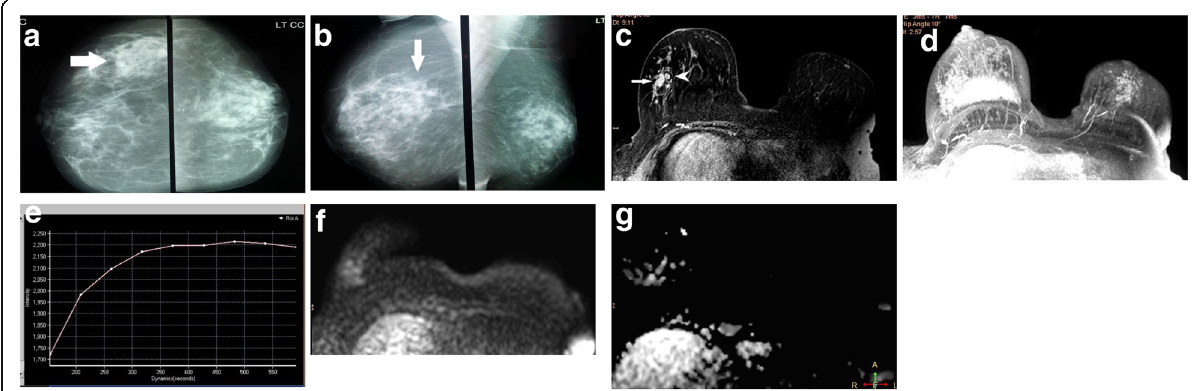
Fig. 4 A 45-year-old female patient with right breast lump. Mammography craniocaudal ( a ) and mediolateral oblique ( b ) views show focal asymmetry (arrow) in the right upper outer quadrant (BIRADS IV lesion). Axial TI contrast-enhanced fat-suppressed image on dynamic sequence ( c ) showed homogenous segmental non-mass enhancement (NME) (arrow) with well-defined enhanced intraductal lesion (arrow head). Axial MIP image ( d ) shows the right breast non-mass enhancement with increased vascularity to right breast. Dynamic time-intensity curve ( e ) shows type II “ plateau ” curve. The lesion elicits faint high signal intensity on DWI at b value = 400 ( f ) with a mean ADC value of 1.2 × 10 – 3 cm/s on ADC map ( g ). MRI findings: BIRADS IV lesion. Histopathological diagnosis: atypical ductal